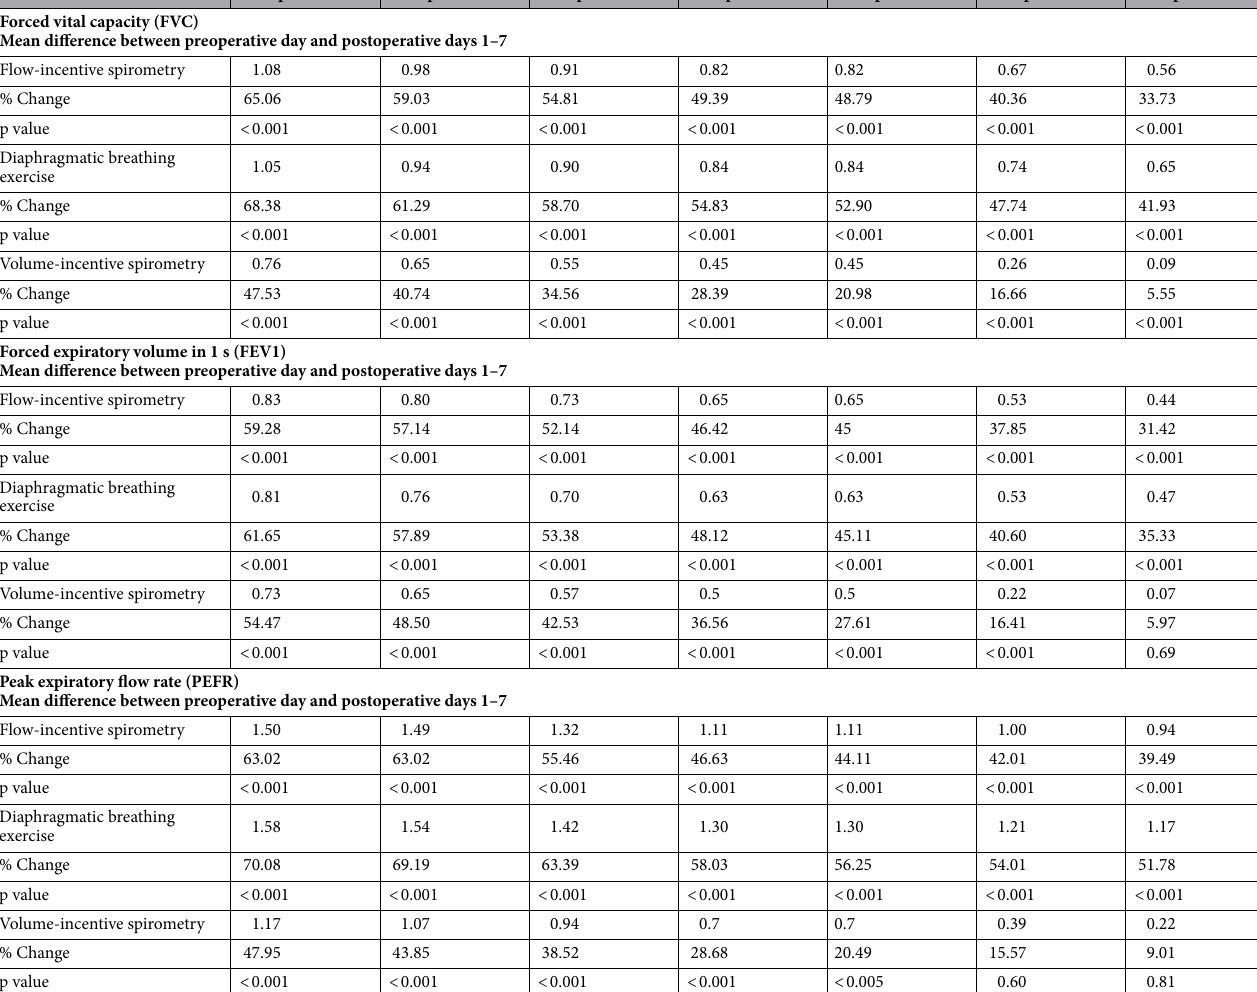
Table 2. Mean difference and percentage change of pulmonary function test values between pre-operative day and post-operative day 1–7 among the three groups. p < 0.001 highly significant, POD postoperative